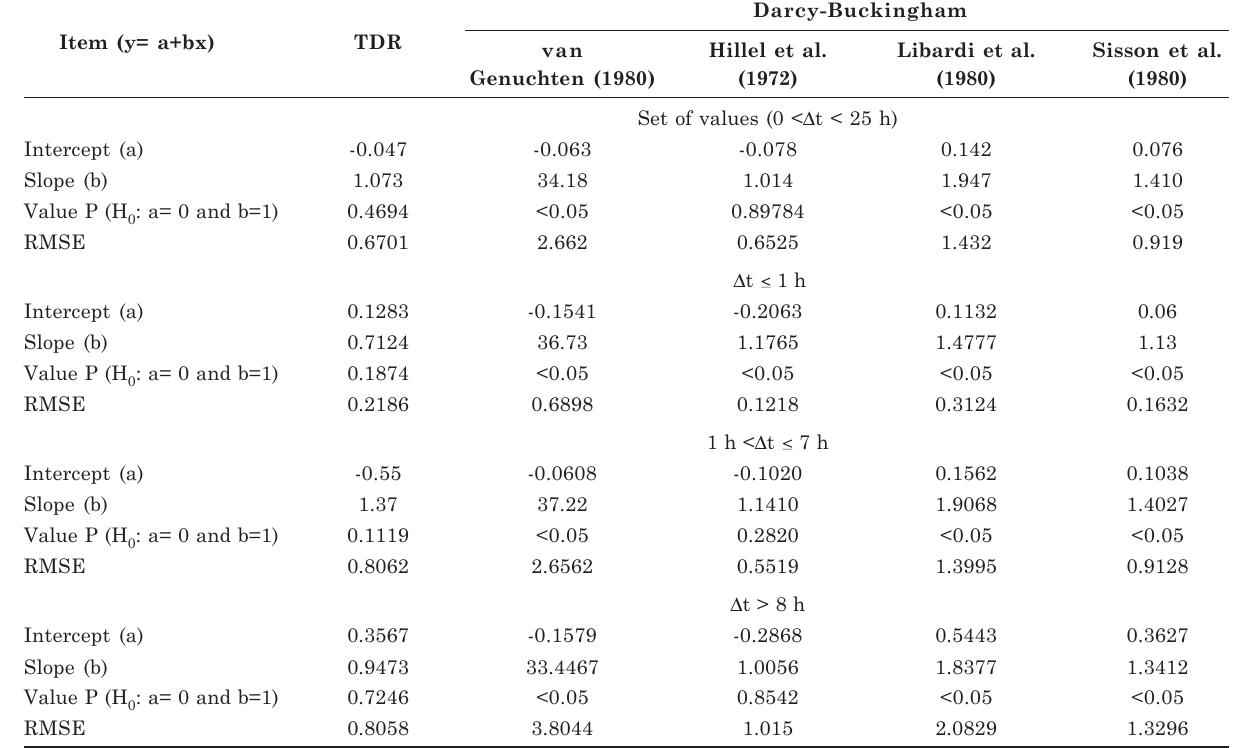
Table 5. Statistics for the regression between the percolation levels observed in lysimeters (y-axis) and estimated (x-axis) by the methods of